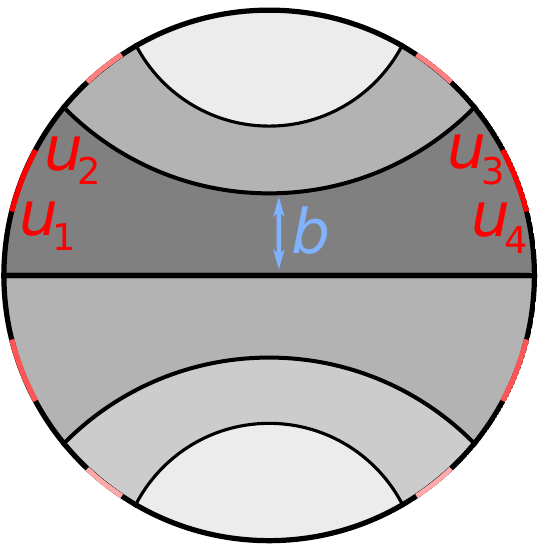
Figure 15 . Here we display the fundamental domain of the double trumpet geometry (dark gray), as well as some of its images (lighter gray). We also show the parts of the boundary where a source is turned on (red) and its images (lighter